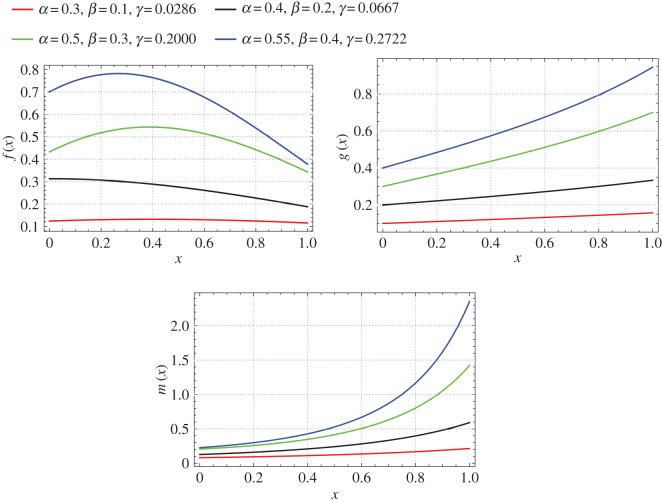
Mass, bending stiffness and mass moment of inertia functions of a non-uniform beam isospectral to a uniform beam (Case 2: α={0.3,0.4,0.5,0.55}, β={0.1,0.2,0.3,0.4}, k=−1, and r0/L=0.09).